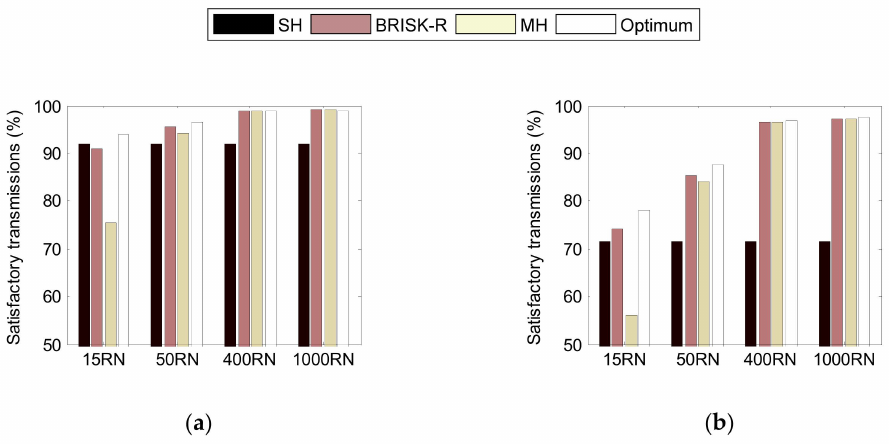
Figure 11. Percentage of satisfactory transmissions—mixed multimedia tra ffi c & homogeneous scenario. ( a ) Email transmissions; ( b ) Web